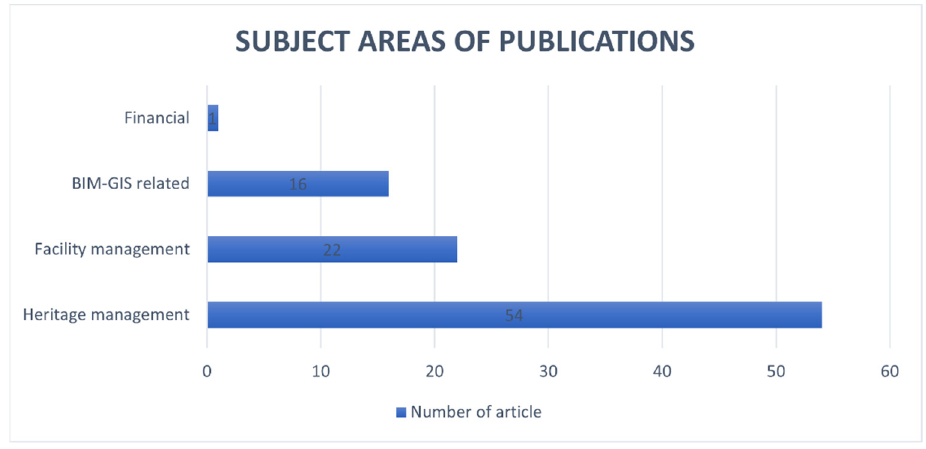
Figure 6. Subject areas of publications.